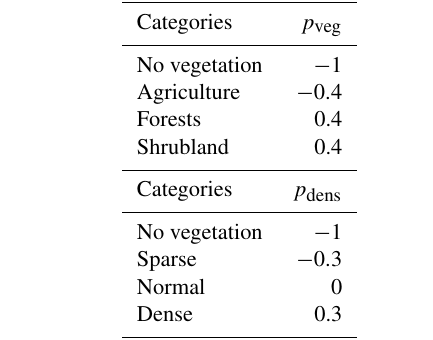
Table 1. Assigned values to loadings of vegetation type ( p veg ) and density ( p dens ).